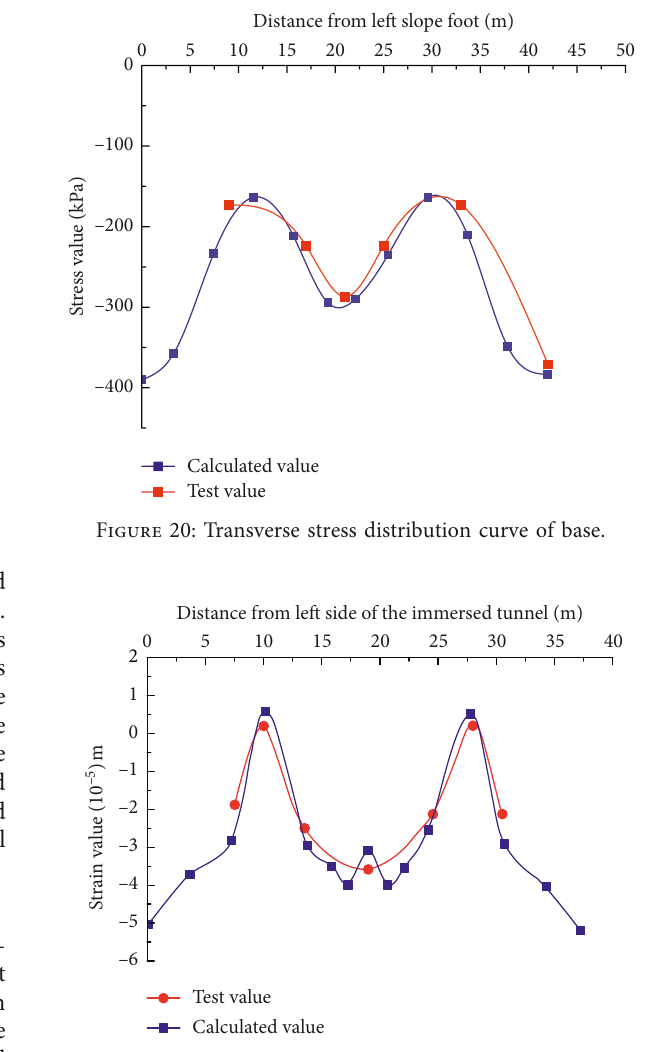
Figure 21: Immersed tunnel strain curve. Table 6: Comparison of